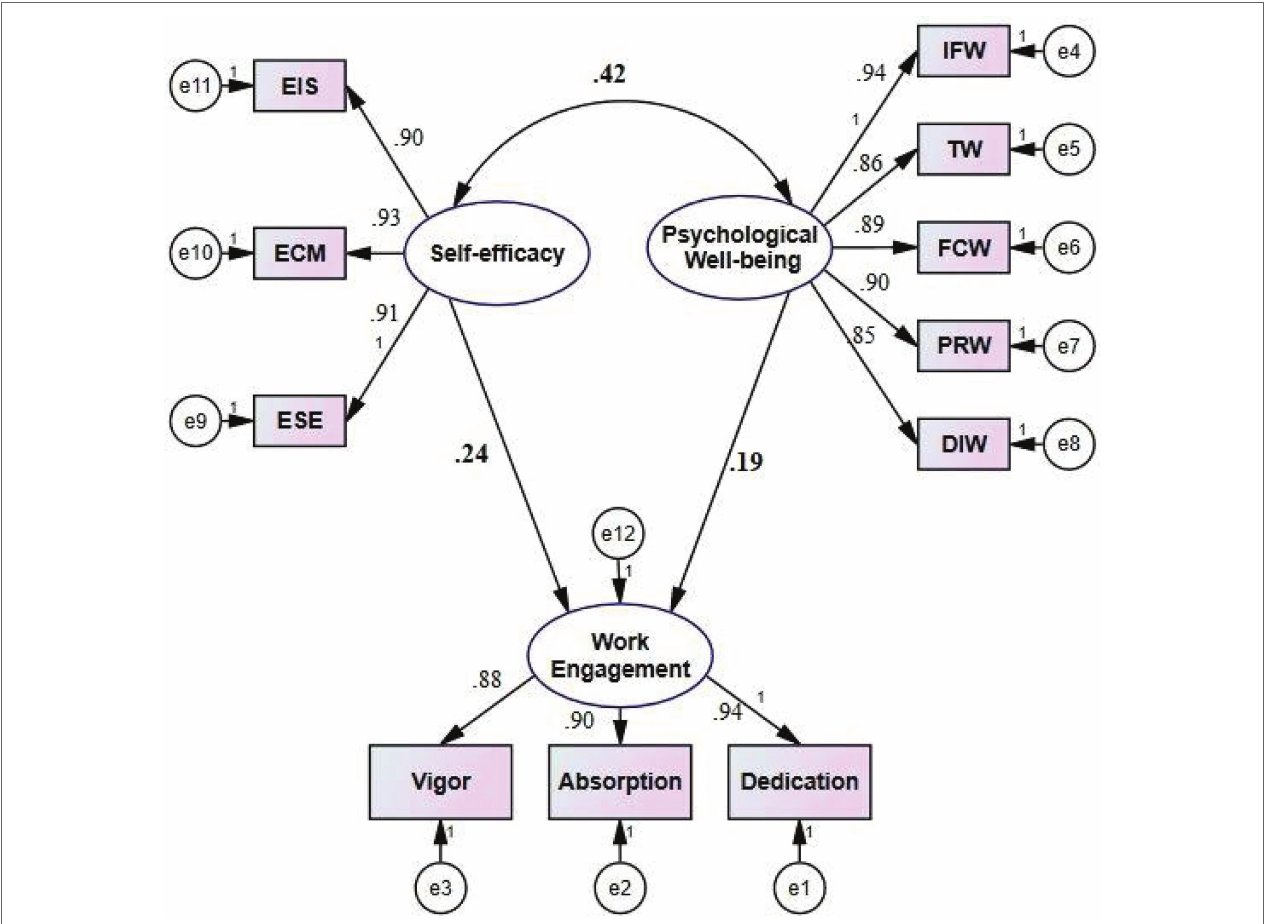
FIGURE 1 | The model of path